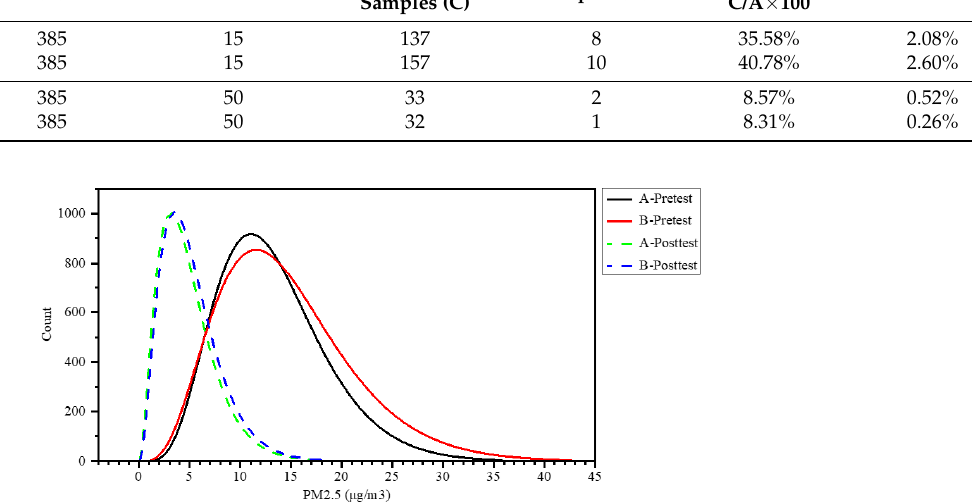
Figure 9. Distribution curve of PM 2.5 concentrations before and after the implementation of the improvement plan.